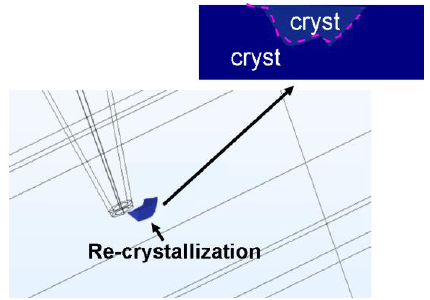
Figure 7. The erasing (re-crystallization) of the previously written amorphous bit in Figure 6a by a 4 V pulse of 100 ns. The inset shows the cross-section image of the re-crystallized bit bounded by the purple dash.